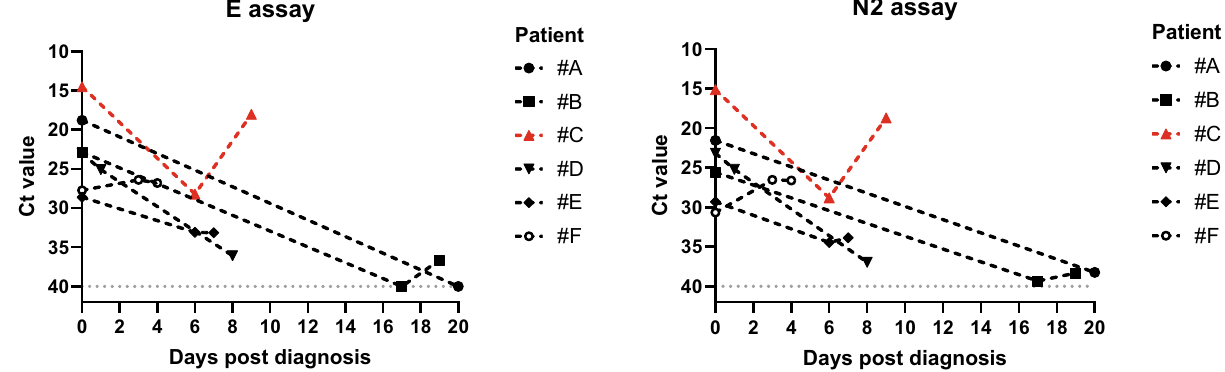
Figure 4. Dynamic changes in virus detection Ct values in patients who received multiple CDI COVID-19 tests after diagnosis during hospitalization. The x-axis uses a relative time scale, where each patient uses his/her own time of diagnosis as the starting point to record the time of each repeat test. Survived patients were shown in black markers and black lines, and non-survivor was shown in red. A virtual Ct value of 40 was used to plot negative detection results (patient #A on day 20 and patient #B on day 17) for E